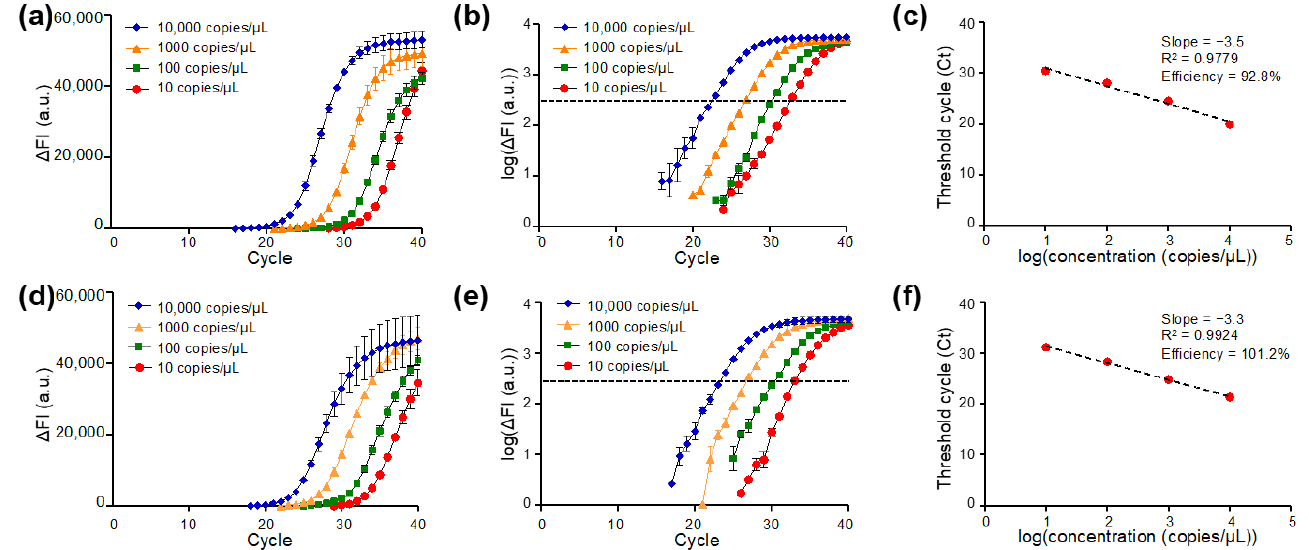
Figure 4. qPCR of the SARS-CoV-2 N gene with U.S. Centers for Disease Control and Prevention (CDC)-referenced N1 or N2 primer-probe set with 1.5 μL droplets on the DMF cartridge: ( a – c ) N gene detected by N1 primer-probe set and ( d – f ) by N2 primer-probe set. qPCR amplification curves of delta fluorescence intensity ( ΔFI ) against cycle number for various template concentrations detected by ( a ) N1 and ( d ) N2 primer-probe sets. Logarithmic plots of ΔFI against cycle number for various concentrations of reactions carried out by ( b ) N1 and ( e ) N2 primer-probe sets. Standard curve and qPCR efficiency of ( c ) N1 and ( f ) N2 primer-probe sets targeting to SARS-CoV-2 N genes on the DMF cartridge ( n = 4 for each concentration).